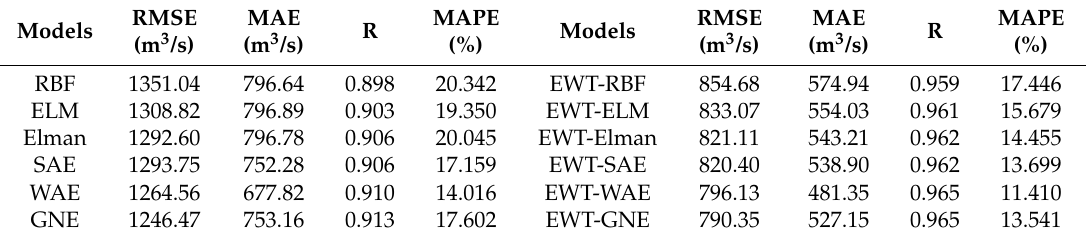
Table 3. The forecasting results of the models in the validation